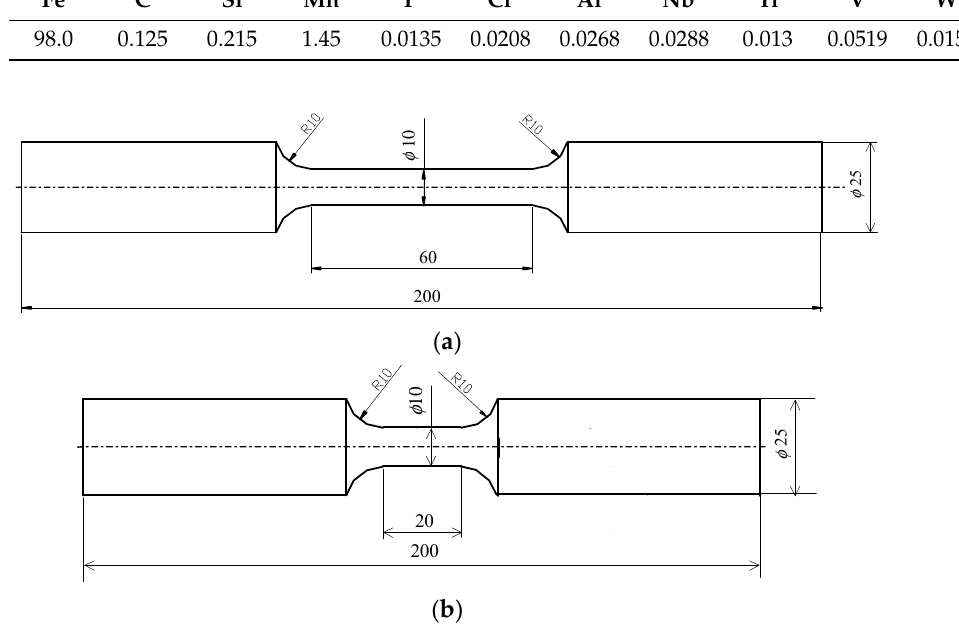
Figure 1. Test specimens: ( a ) for tensile testing, ( b ) for low-cycle fatigue testing (dimensions are given in mm).